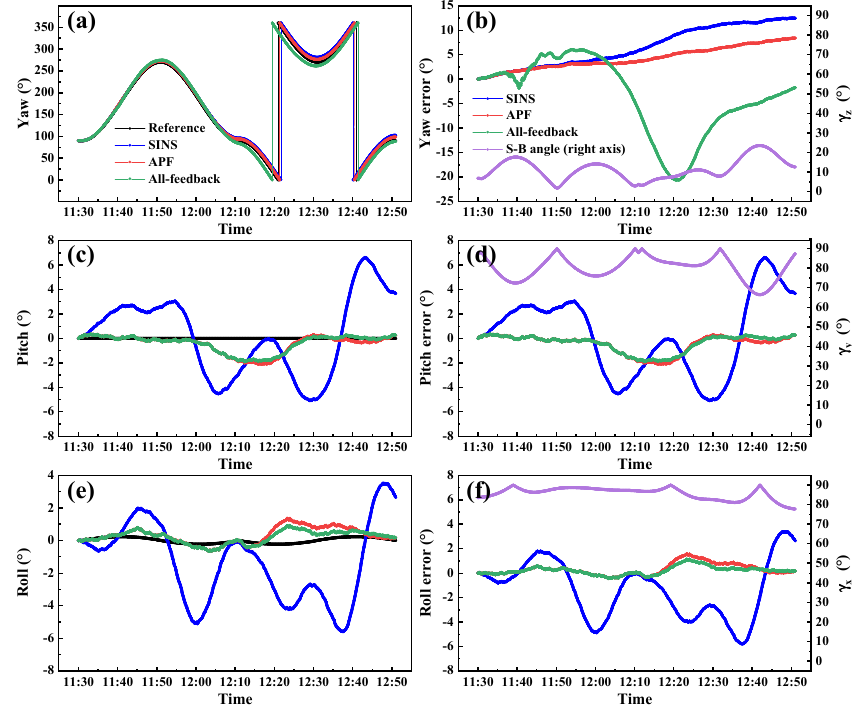
Table 6. Attitude estimation error statistics of dynamic simulation.